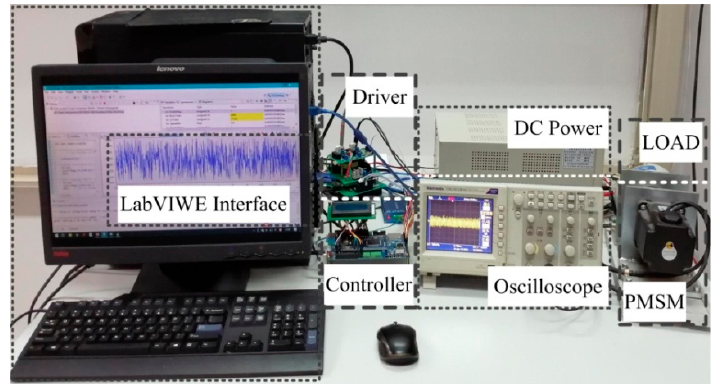
Figure 6. Experimental setup of control system.